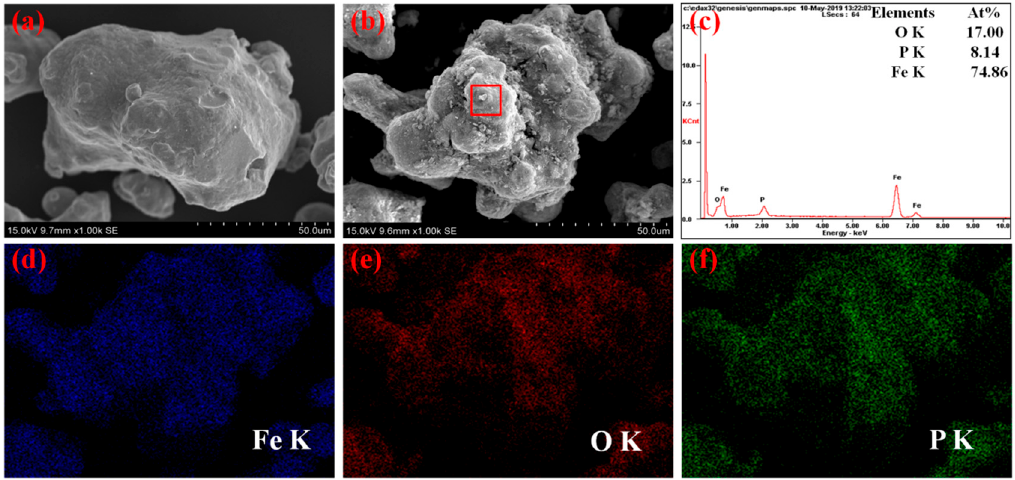
Figure 1. SEM images of the powders ( a ) pure iron powder, ( b ) phosphated iron powder, ( c ) EDS analysis of the selected area and EDS maps of ( d ) iron, ( e ) oxygen and ( f ) phosphorus of phosphated powders.